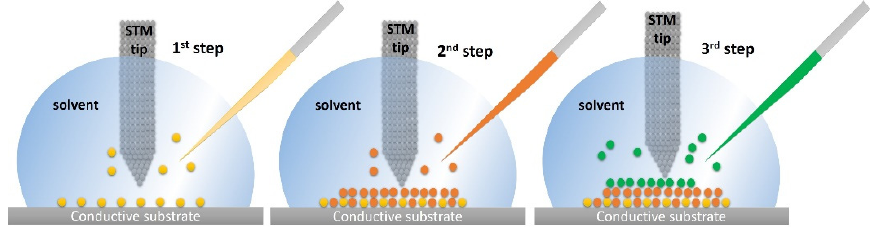
Figure 3. Illustration of a step-by-step method used to build supramolecular structures with STM at the solid/liquid interface. Reproduced from [31] with permission from the Creative Common CC BY license.